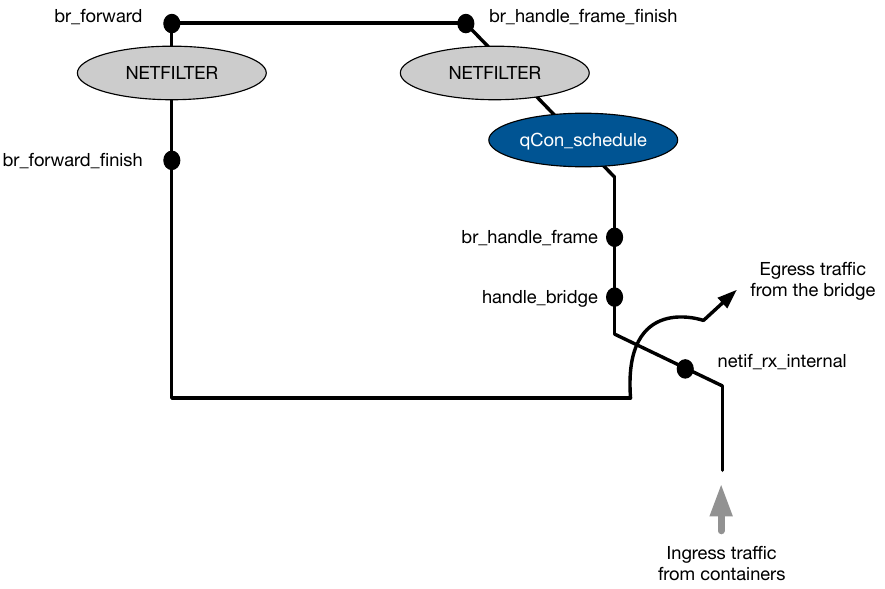
Figure 5. Scheduling function of qCon implemented in the Linux